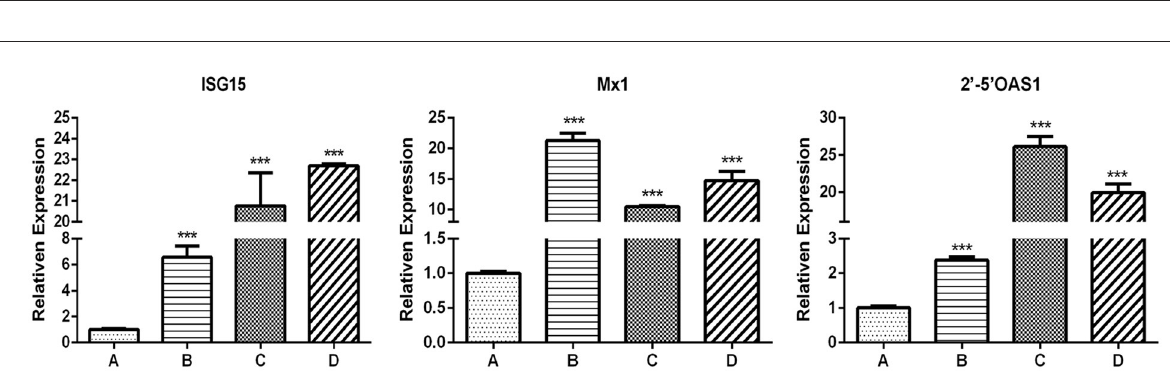
FIGURE7 Expression of antiviral genes induced for 24h by INF- ε in different F81 groups. (A) Cell control group. (B) VSV-GFP control group. (C) IFN- ε group. (D) MiIFN- ε -inhibited VSV-GFP group[[Inline Image]]. Compared with group A, the expression levels of ISG15, Mx1 and 2’-5’OAS in group B, C and D increased and displayed significant differences ( p < 0.001), *** indicates p <